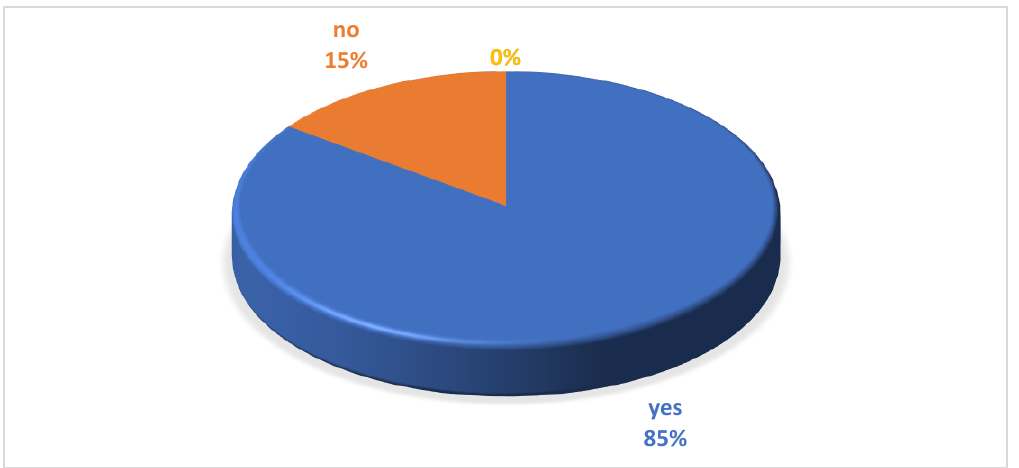
Figure 13. Support for investments in renewable energy sources in the commune.